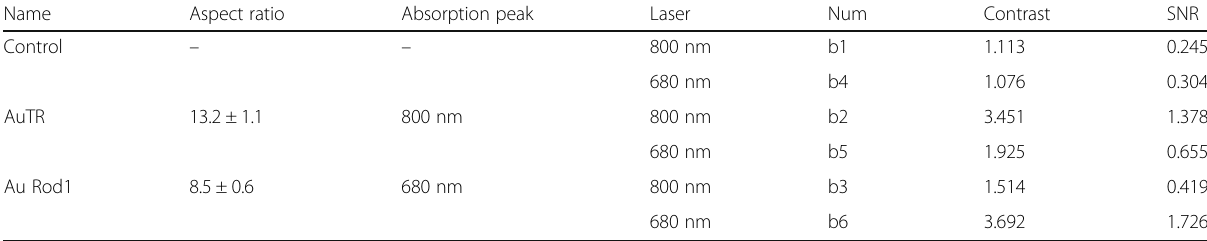
Table 1 Comparison of contrast and SNR in PA images from b1 to b6 in Fig. 5. Contrast here is a mean value of the images for mice cerebral blood vessels; SNR in the table here denotes signal-noise ratio, which is the analysis of the whole